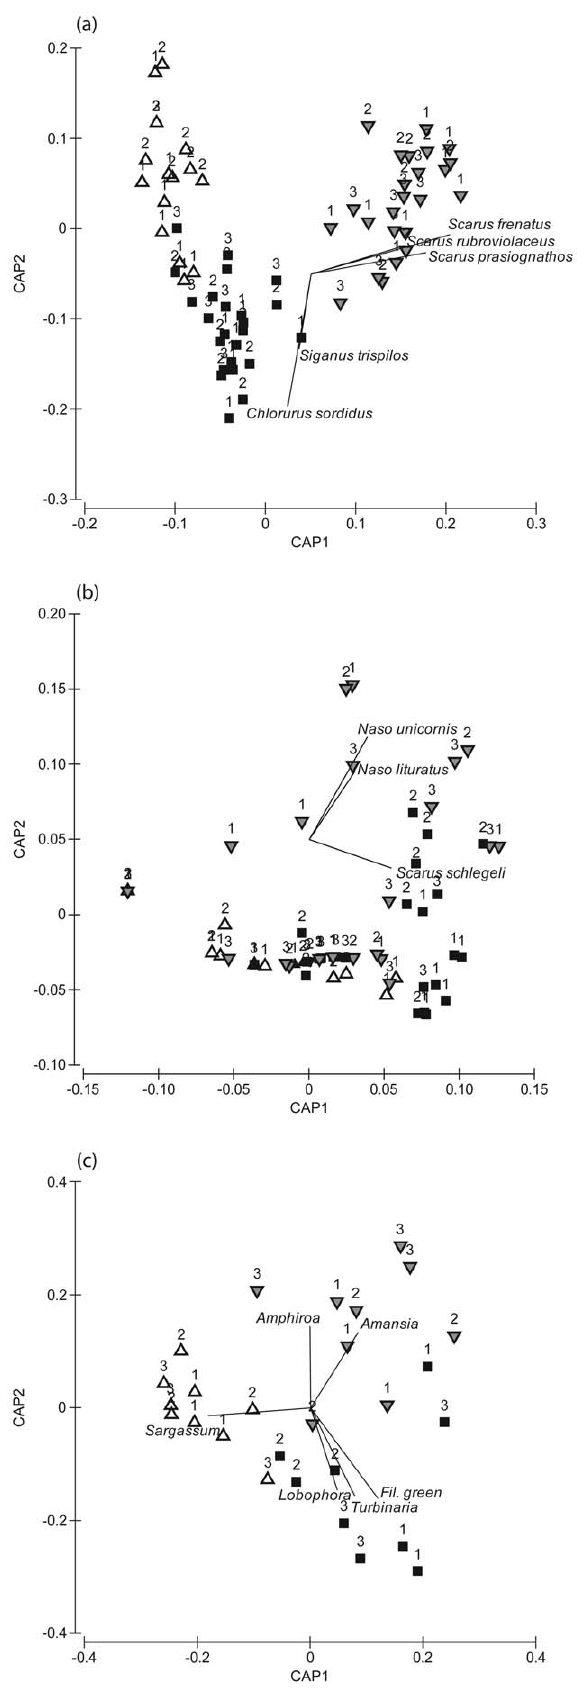
Figure 3. Seascape patterns in the distribution of fish and algae assemblages. Canonical analysis of principal coordinates (CAP) comparing community assemblages of (a) all roving herbivorous fish, (b) all browsing fish, and (c) macroalgae between sites (numbered icons) and habitats (symbols): Triangles facing upwards = Lagoon; Triangles facing downwards = Outer reef; Squares = Reef flat habitat. Data were fourth-root transformed prior to